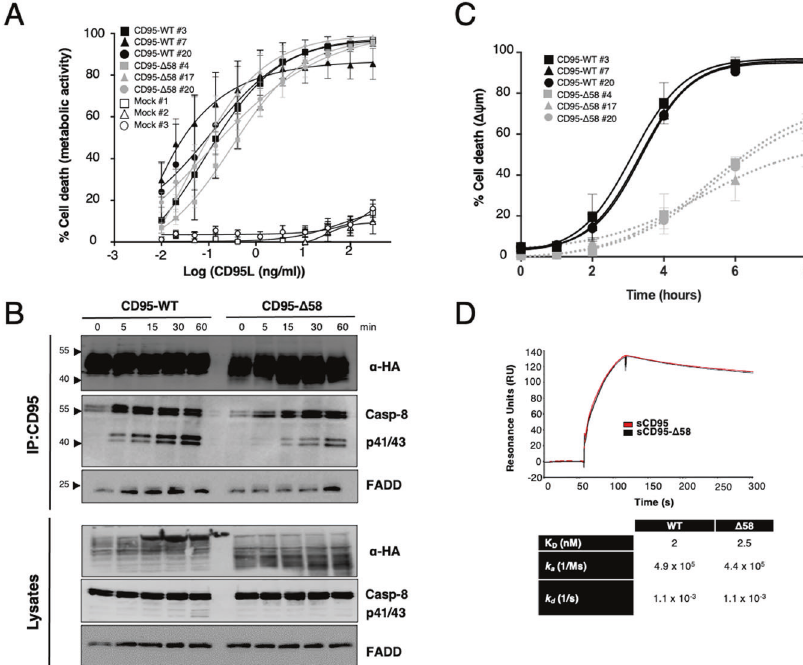
Fig. 5 Elimination of the CD95 amino terminal region impinges on the apoptotic signal. A CEM-IRC clones stably expressing full-length CD95, CD95- Δ 58 or empty vectors were incubated for 24 h with the indicated concentrations of cytotoxic IgCD95L and cell death was assessed by MTT assay. Data represent mean ± SD of three independent experiments. B Full-length or CD95- Δ 58-expressing CEM-IRC clones were incubated with IgCD95L (100 ng/mL) for the indicated times. Cells were then lyzed and CD95 was immunoprecipitated using the APO1-3 antibody. The quantity of co-immunoprecipitated FADD and caspase-8 was evaluated by immunoblotting. Data are representative of three independent experiments. C Full-length and CD95- Δ 58-expressing CEM-IRC cells were incubated for indicated time points with IgCD95L (100 ng/ml) and the drop of mitochondrial potential ( ΔΨ m ) was assessed. Data represent mean ± SD of three independent experiments. D Surface plasmon resonance analyses of CD95L binding to immobilized soluble full-length extracellular domain of CD95 (sCD95) or its Δ 58 counterpart (sCD95- Δ 58). The kinetic parameters are listed in the bottom